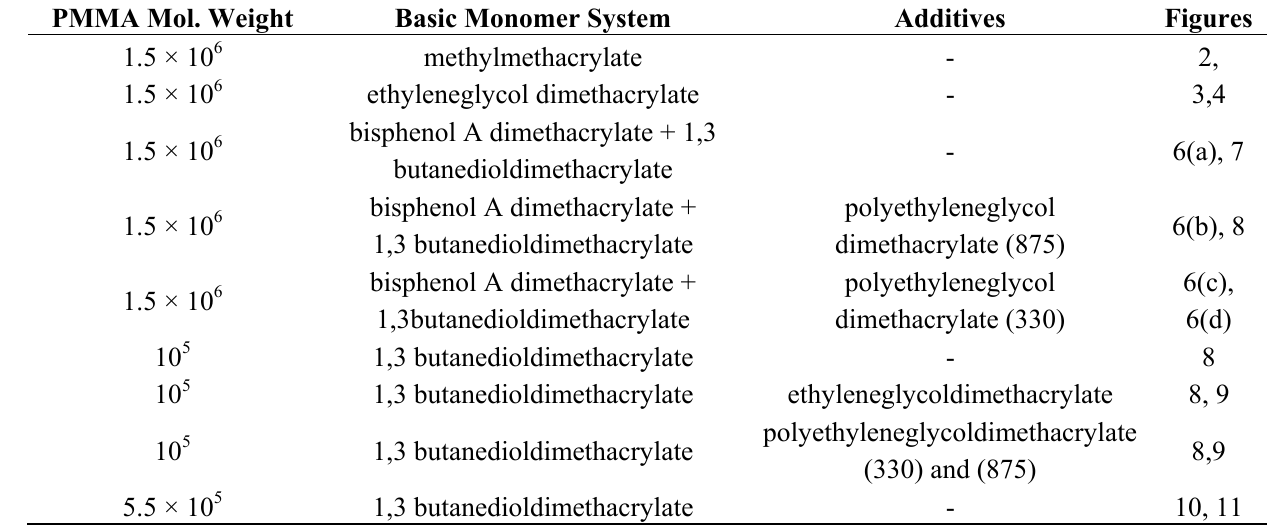
Table 1. Main systems and chemical composition